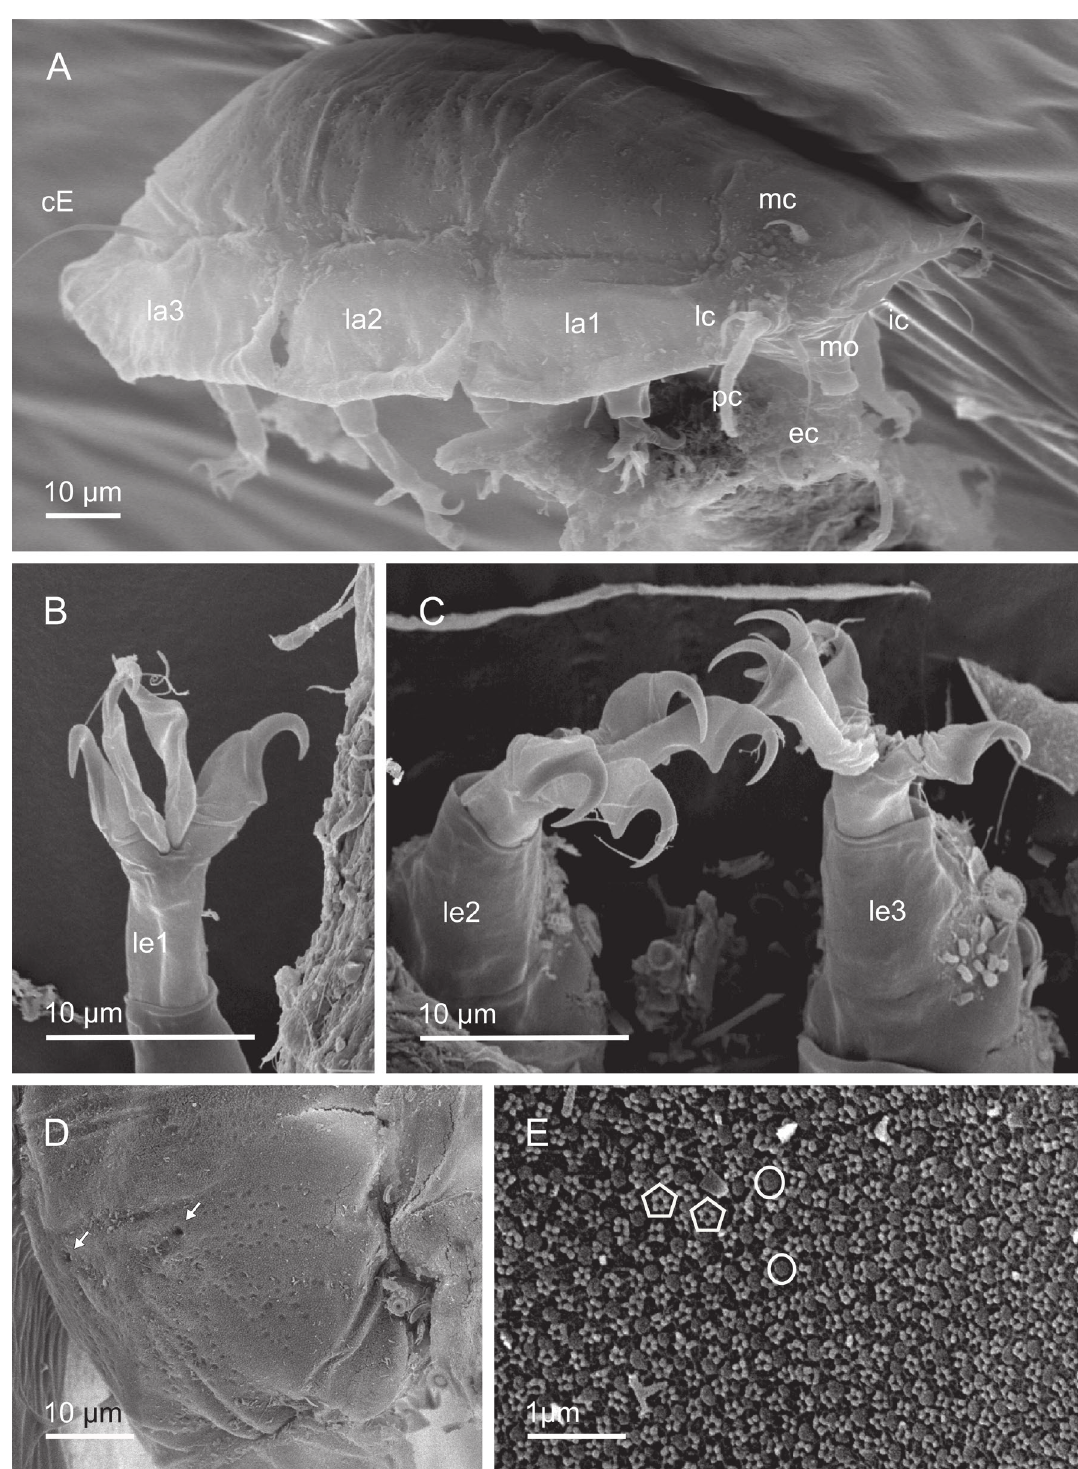
Fig 5. SEM-micrographs of Higginsarctus signeae gen. et sp. nov., paratype, ♀ (NHMD-293902). A . Dorso-lateral overview. B . Digits and claws of leg I. C . Digits and claws of leg II and leg III. D . Caudal end, dorsal view. Arrows indicate the large dorsal pores. E . Close up on the sculpture of the dorsal cuticle. The small knob-like structures arranged in rosettes are indicated by white polygons. The larger knob-like structures are indicated by white circles. Abbreviations: see Material and